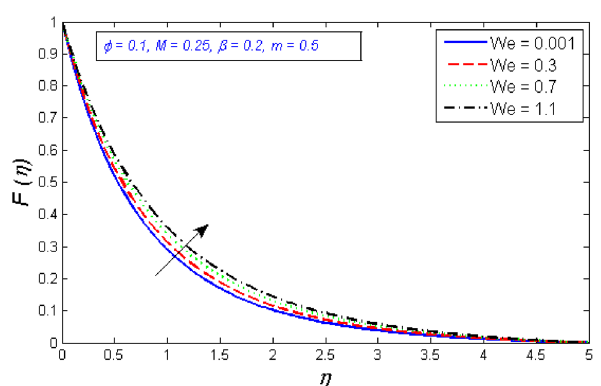
Figure 4. Variation of radial velocity distribution for several number of Ree-Eyring Weissenberg number We